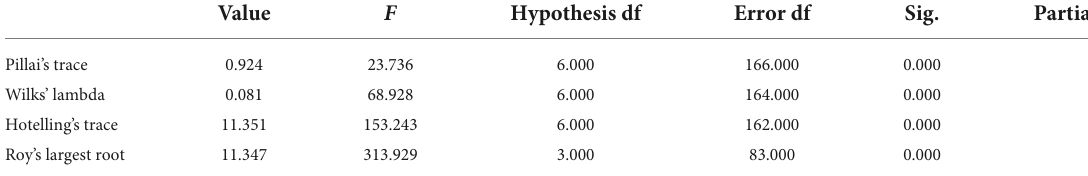
TABLE 7 Results of multivariate tests.